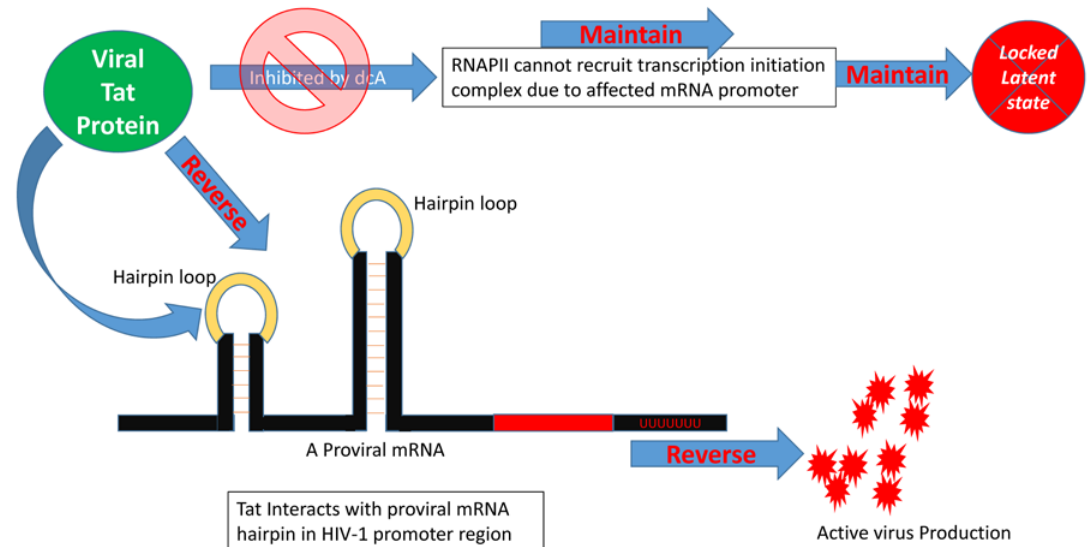
Figure 3. HIV Tat protein and latency reversal. Tat protein can reverse HIV latency by interacting with the promoter region of the HIV genome through recruiting RNAPII and associated transcription initiation complex. This process is affected by didehydro-cortistatin A (dCA). When RNAPII becomes unable to interact with the HIV mRNA hairpin loop, the latency reversal is halted. A thorough investigation of the roles of individual viral proteins in HIV latency reversal is thus very important for understanding their critical role in HIV cure.